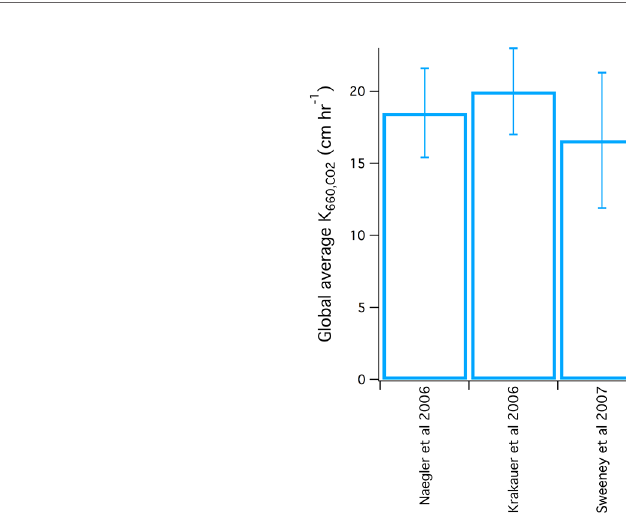
FIGURE 9 | Global average K 660 estimates from 14 C (see Naegler, 2009) and implied from EC measurements, the latter based on CCMP wind distribution. The error bar on the EC estimate represents standard